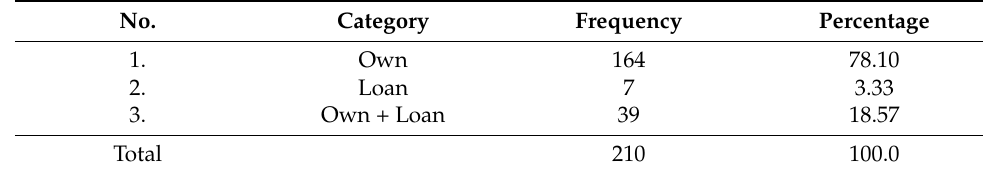
Table 3. Distribution of MSME actors in agriculture by financial capital. No. Category Frequency Percentage